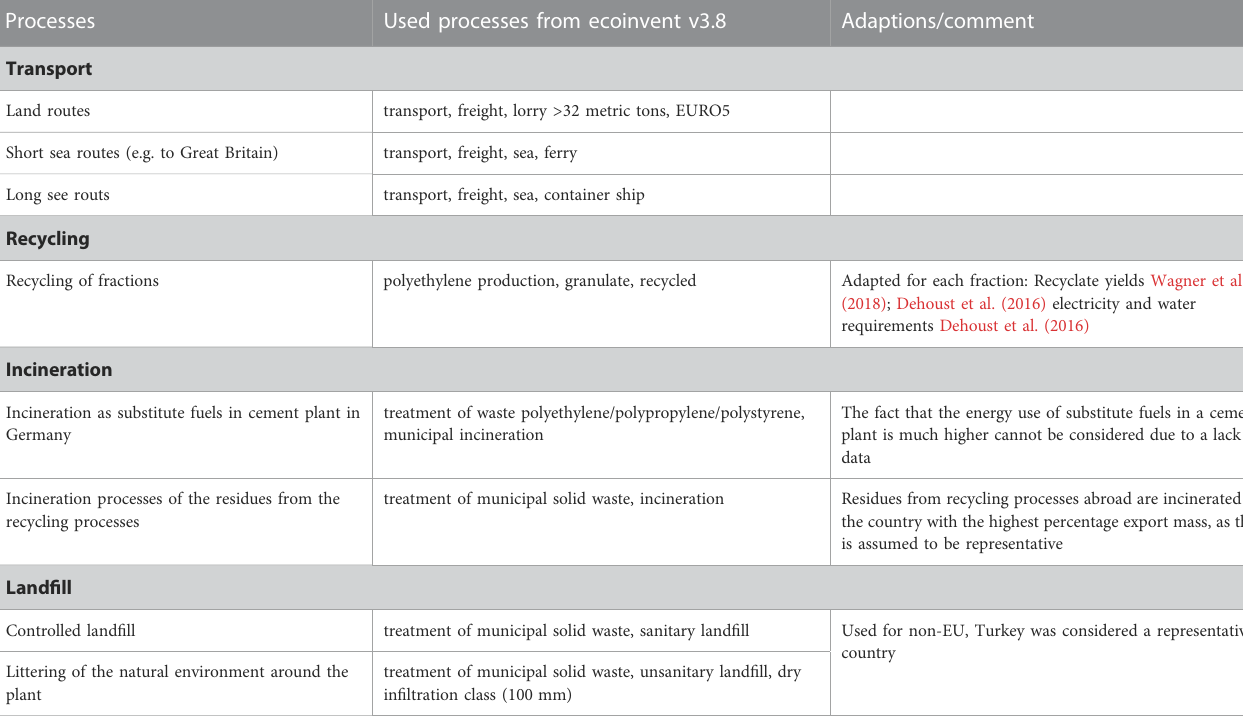
TABLE 1 Used processes from ecoinvent v3.8 and adaptions. Processes Used processes from ecoinvent